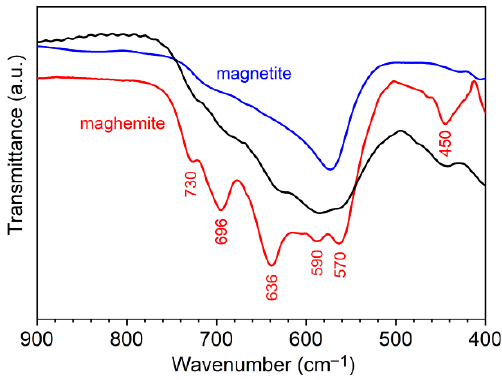
Figure 3. FTIR spectra of iron oxide NPs (black) compared to spectra of neat magnetite (blue) and maghemite (red) powders. Spectra with entire wavenumber range are displayed in Figure A7. Otherwise, the average crystallite size calculated from the PXRD peak width with the Scherrer equation, ∆ (2 θ ) = 0.9 λ /(Lcos( θ 0 )) equals 13 ± 4 nm. This value is in good agreement with the average NP diameter of 13 nm determined by TEM (Figure 4) and the diameter of 14 ± 2 nm determined by DLS (Figure A3).